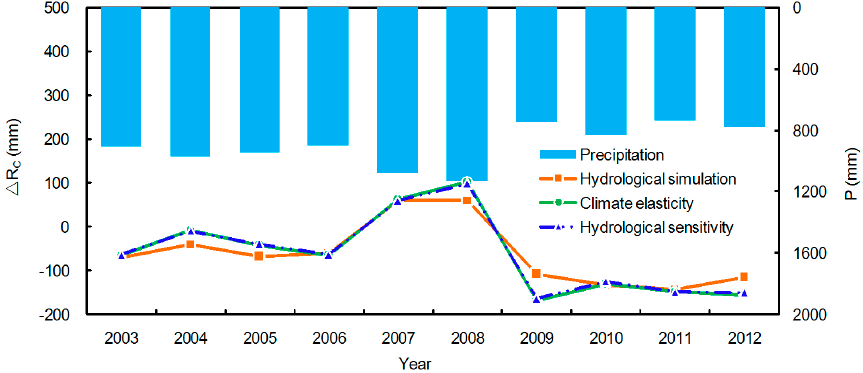
Figure 7. Time series of Δ R C , estimated by hydrological sensitivity, climate elasticity, and hydrological simulation methods in the URRB (2003–2012).